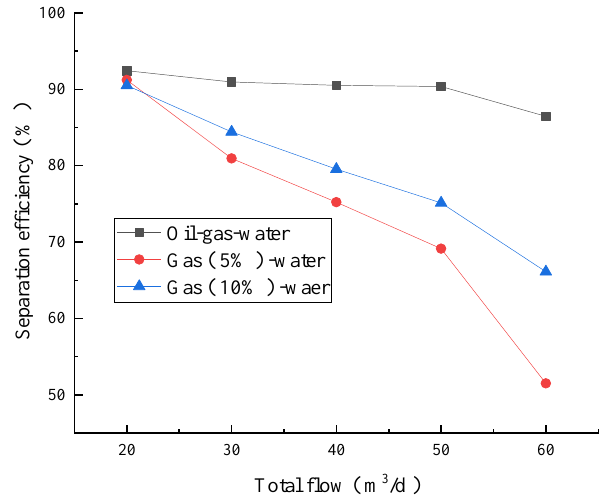
Figure 8. Gas–liquid separation efficiency curve at two-phase flow and multiphase Figure 8. Gas – liquid separation efficiency curve at two-phase flow and multiphase flow.